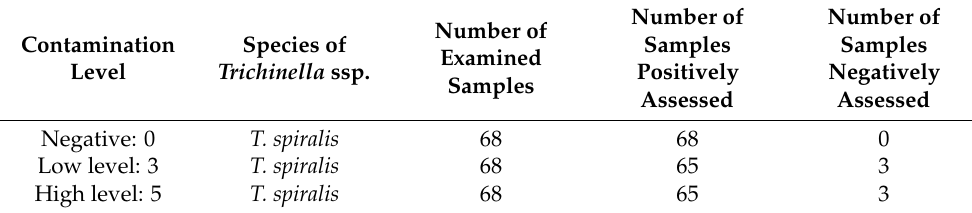
Table 8. The PT’s results used for the calculation of sensitivity, specificity, and accuracy of the MSD for horse meat matrix.